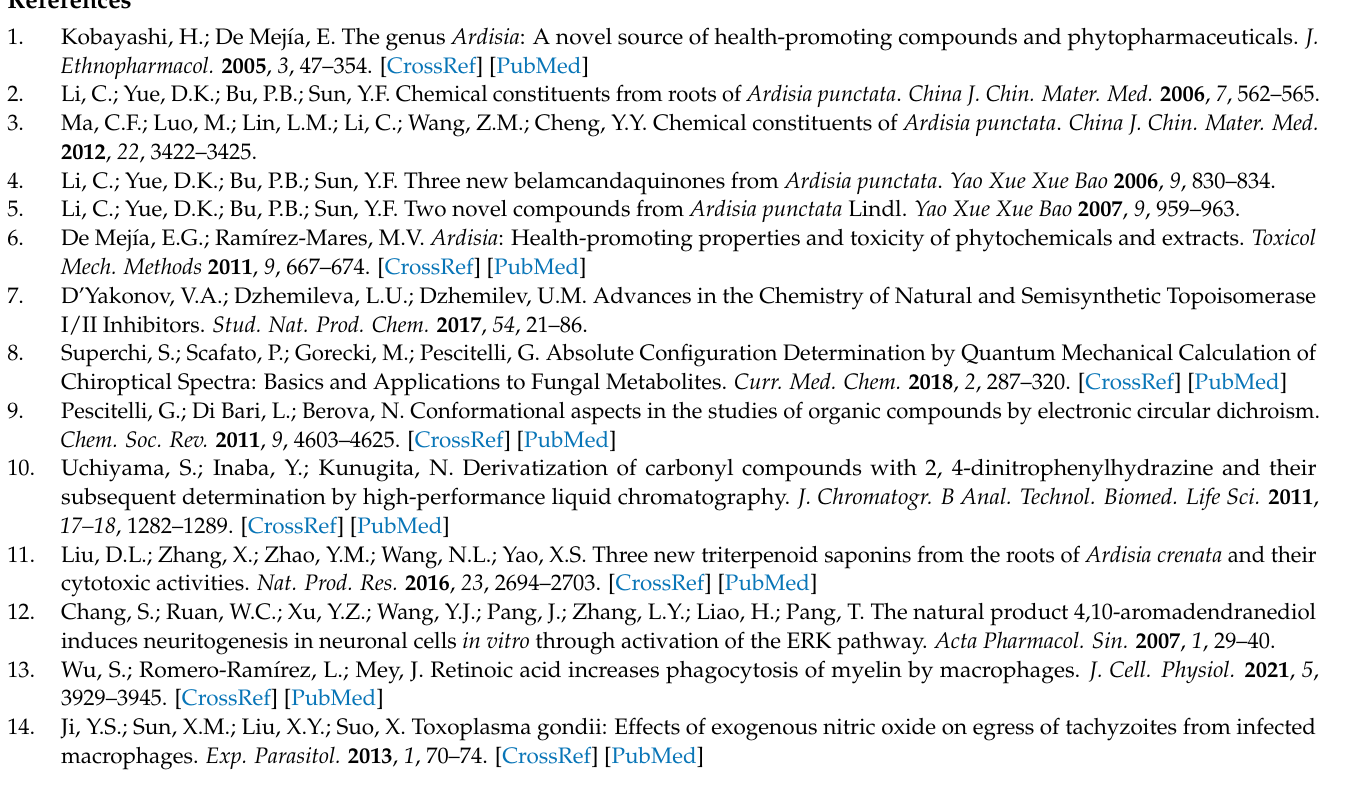
S2: 13 C NMR spectrum of 1 . Figure S3: DEPT spectrum of 1 . Figure S4: HSQC spectrum of 1 . Figure S5: HMBC spectrum of 1 . Figure S6: 1 H- 1 H COSY spectrum of 1 . Figure S7: NOESY spectrum of 1 . Figure S8: HR-ESI-MS spectrum of 1 . Figure S9: HPLC–UV chromatogram of 1 . Figure S10: HPLC–ELSD chromatogram of 1 . Figure S11: Ultraviolet full wavelength scanning spectrum of 1 . Figure S12: IR spectrum of 1 . Figure S13: 1 H NMR spectrum of 2 . Figure S14: 13 C NMR spectrum of 2 . Figure S15: DEPT spectrum of 2 . Figure S16: HSQC spectrum of 2 . Figure S17: HMBC spectrum of 2 . Figure S18: 1 H– 1 H COSY spectrum of 2 . Figure S19: NOESY spectrum of 2 . Figure S20: HR–ESI–MS spectrum of 2 . Figure S21: HPLC–UV chromatogram of 2 . Figure S22: HPLC–ELSD chromatogram of 2. Figure S23: Ultraviolet full wavelength scanning spectrum of 2. Figure S24: IR spectrum of 2. Figure S25: 1 H NMR spectrum of 2–DNP . Figure S26: 13 C NMR spectrum of 2–DNP . Figure S27: DEPT spectrum of 2–DNP . Figure S28: HSQC spectrum of 2–DNP . Figure S29: HMBC spectrum of 2– DNP . Figure S30: 1 H– 1 H COSY spectrum of 2–DNP . Figure S31: NOESY spectrum of 2–DNP . Figure S32: HR–ESI–MS spectrum of 2–DNP . Figure S33: HPLC–UV chromatogram of 2–DNP . Figure S34: HPLC–ELSD chromatogram of 2–DNP . Figure S35: Ultraviolet full wavelength scanning spectrum of 2–DNP . Figure S36: IR spectrum of 2–DNP